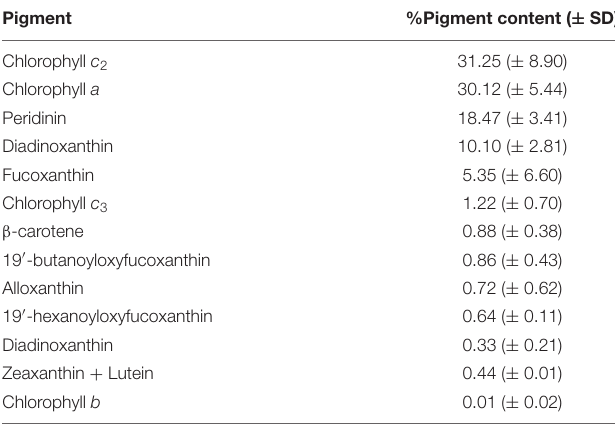
TABLE 1 | Percentage of pigment content (average% ± SD) of Cotylorhiza tuberculata symbionts (Symbiodiniaceae) from High Performance Liquid Chromatography (HPLC)